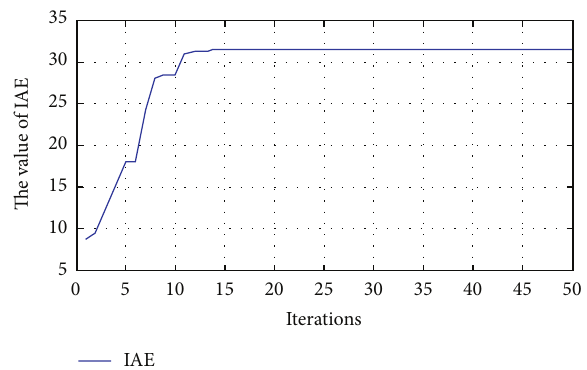
Figure 7: Convergence characteristics of PSO algorithm.